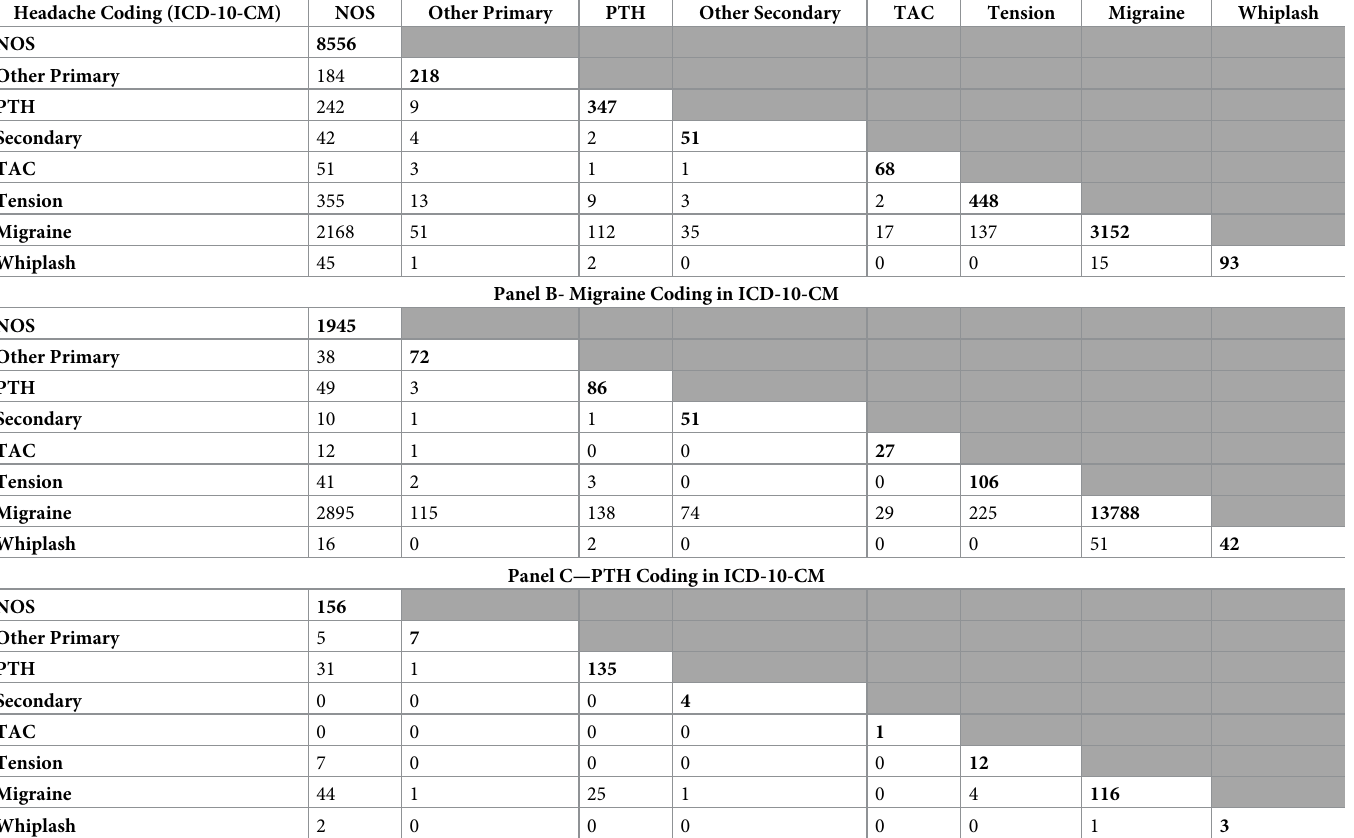
Table 2. Specificity of ICD-10-CM headache coding among patients who were diagnosed with headache diagnosis of NOS, migraine, or PTH based on ICD-9-CM. Panel A—Headache NOS Coding in ICD-10-CM